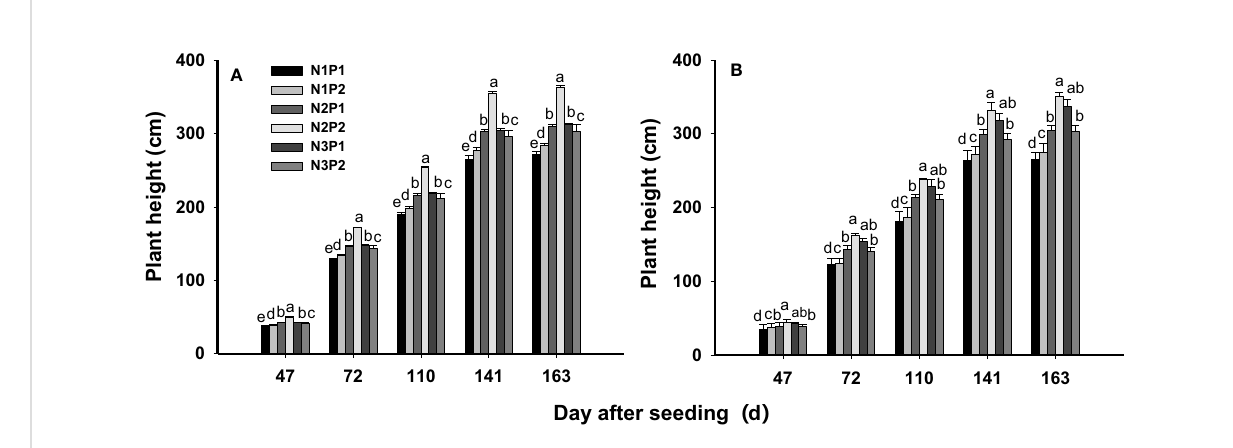
FIGURE 2 Effects of different nitrogen and phosphorus combinations on plant height of sesbania pea at different growth stages in saline soils. Different letters indicate signi fi cant differences between different treatments at same growth stage at P<0.05 level. (A) : 2020, (B) :